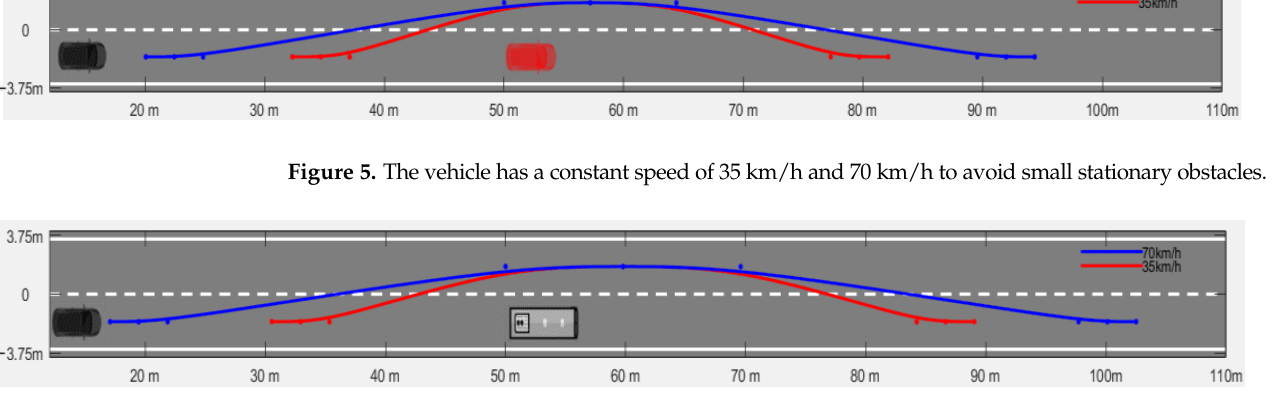
Figure 6. The vehicle has a constant speed of 35 km/h and 70 km/h to avoid large stationary obsta- cles.